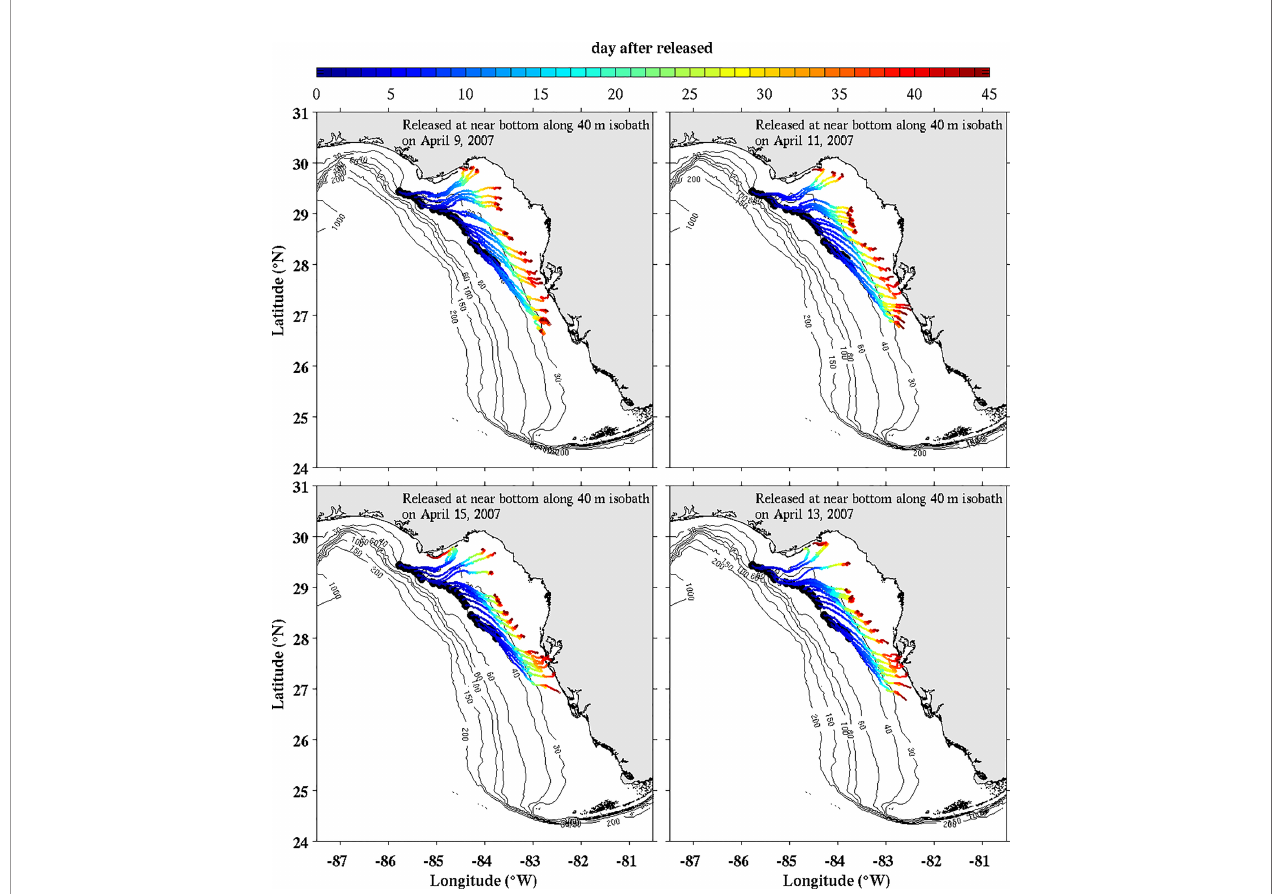
FIGURE 11 | WFCOM-simulated near-bottom particle trajectories for particles initialized on the 40 m isobath. Clockwise from the upper left hand panel are particles initialized on April 9, April 11, April 13 and April 15, 2007. Color-coding denotes particle age from initialization at day zero to 45 days (from Weisberg et al.,